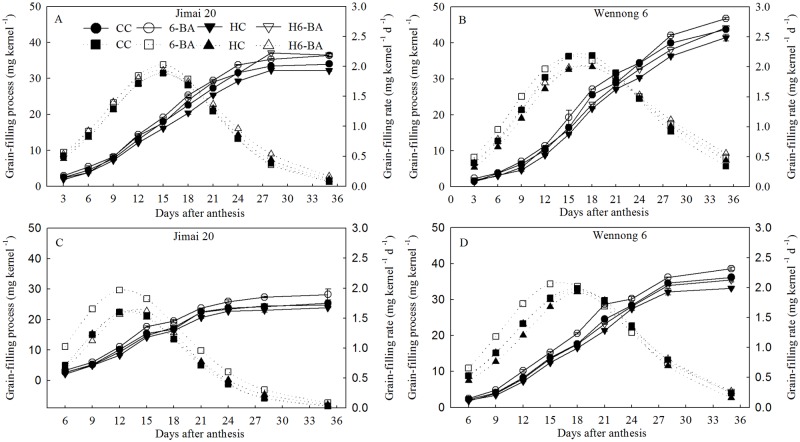
Grain weight and grain-filling rate for superior (A, B) and inferior kernels (C, D).CC and 6-BA represent treatments with water and 6-BA under non-heated condition, respectively. HC and H6-BA represent treatment with water and 6-BA under heated condition, respectively. Solid line and dotted line represent endosperm grain weight and grain-filling rate, respectively. Vertical bars represent ± standard error of the mean (n = 3) where they exceed the size of the symbol.